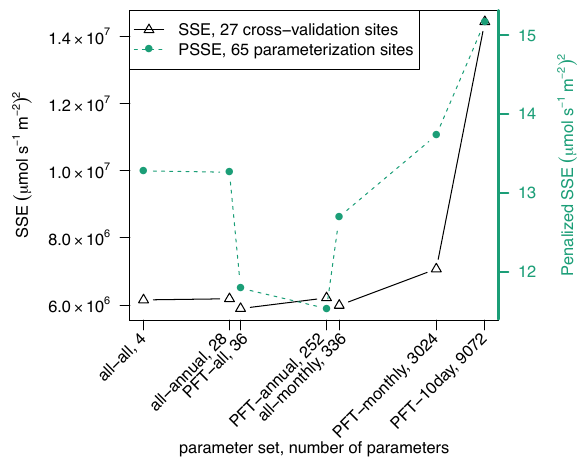
Fig. 3. VPRM sum of squared errors vs. number of unique param- eter values. Shown are the seven VPRM parameter sets available for upscaling. Parameter sets are labeled as (space grouping) − (time grouping) used for VPRM parameter estimation. Left vertical axis shows sum of squared errors (SSE) for the 27 cross-validation sites not used to estimate VPRM parameters (Fig. 2, Table 1); right ver- tical axis shows penalized sum of squared errors (PSSE) for the 27 cross-validation sites combined with the 65 sites used to parame- terize VPRM (Fig. 1, Table 1). Note the log-scale on the horizontal